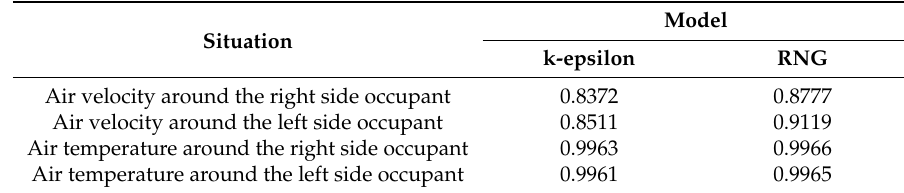
Table 3. Air velocity and the temperature accuracy obtained in the validation tests using the k-epsilon and RNG turbulence models.